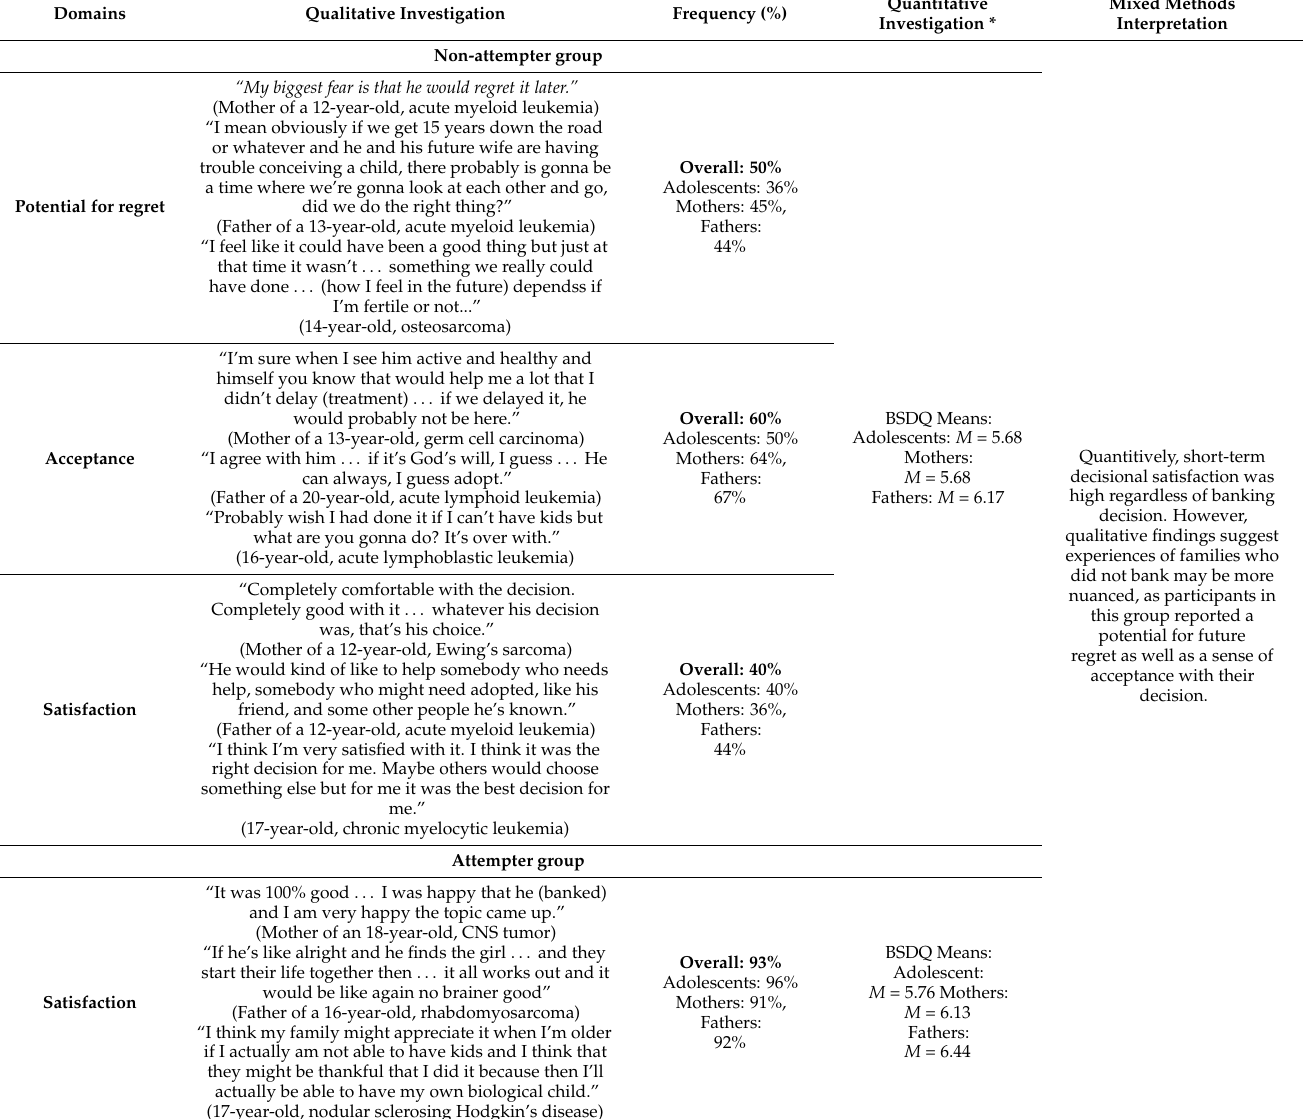
Table 4. Joint display of decision quality among non-attempters and